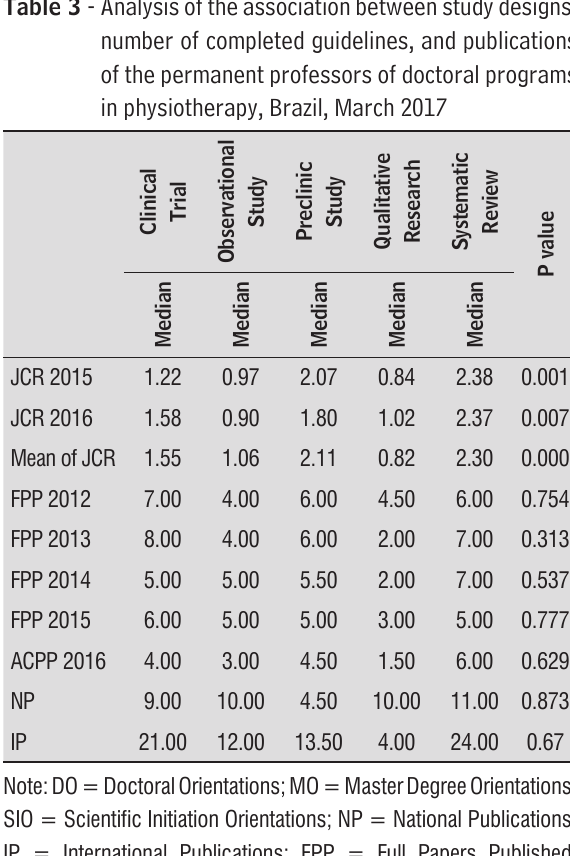
Table 2 - Descriptions of quantitative variables selected on